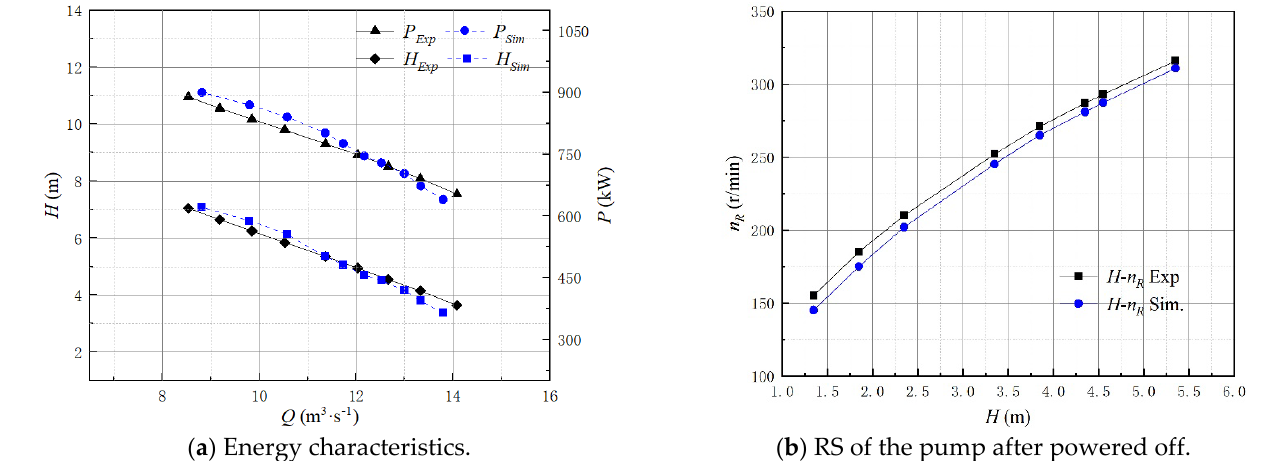
Figure 8. Comparison of the experimental results and simulation results.